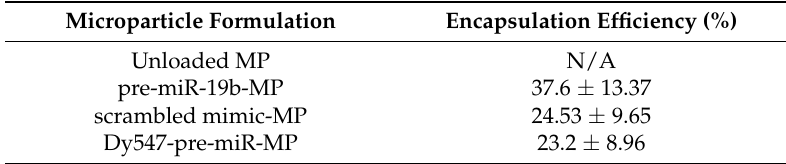
Table 2. Summary of percent encapsulation efficiency of PLGA microparticles (means ± SD).